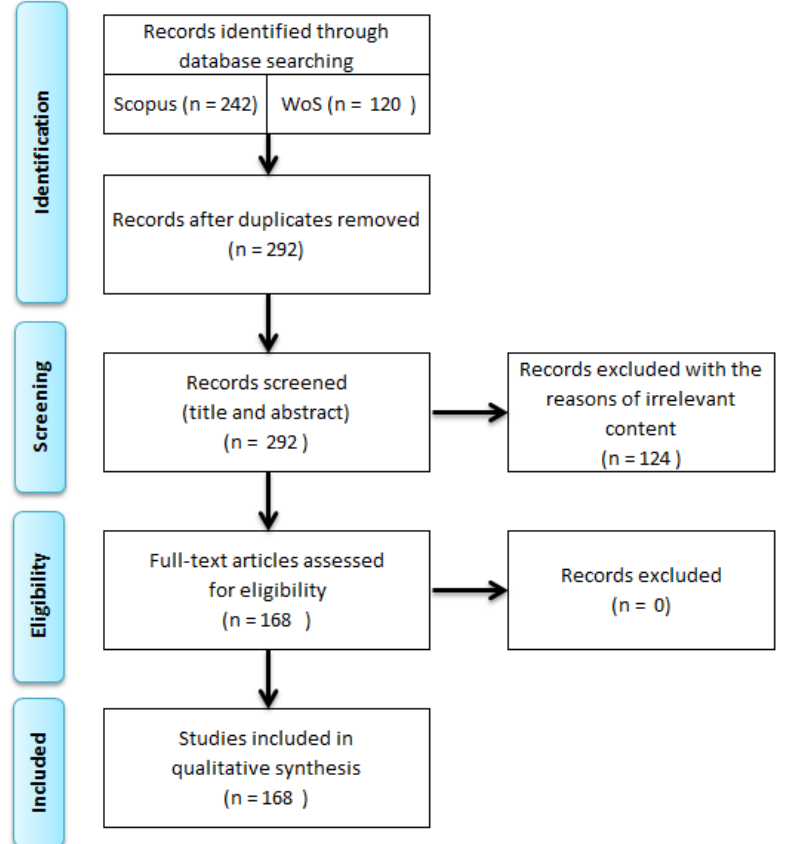
Figure 1. Flow diagram of identification, screening and inclusion of studies.